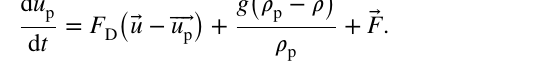
model within the spray model theory (Taylor analogy breakup (TAB) model or wave model) is used to compute the droplet breakup based on the particle Weber number. In addition, the outcomes of the collision model are used for modeling droplet coalescence (Laleh et al. 2012a,